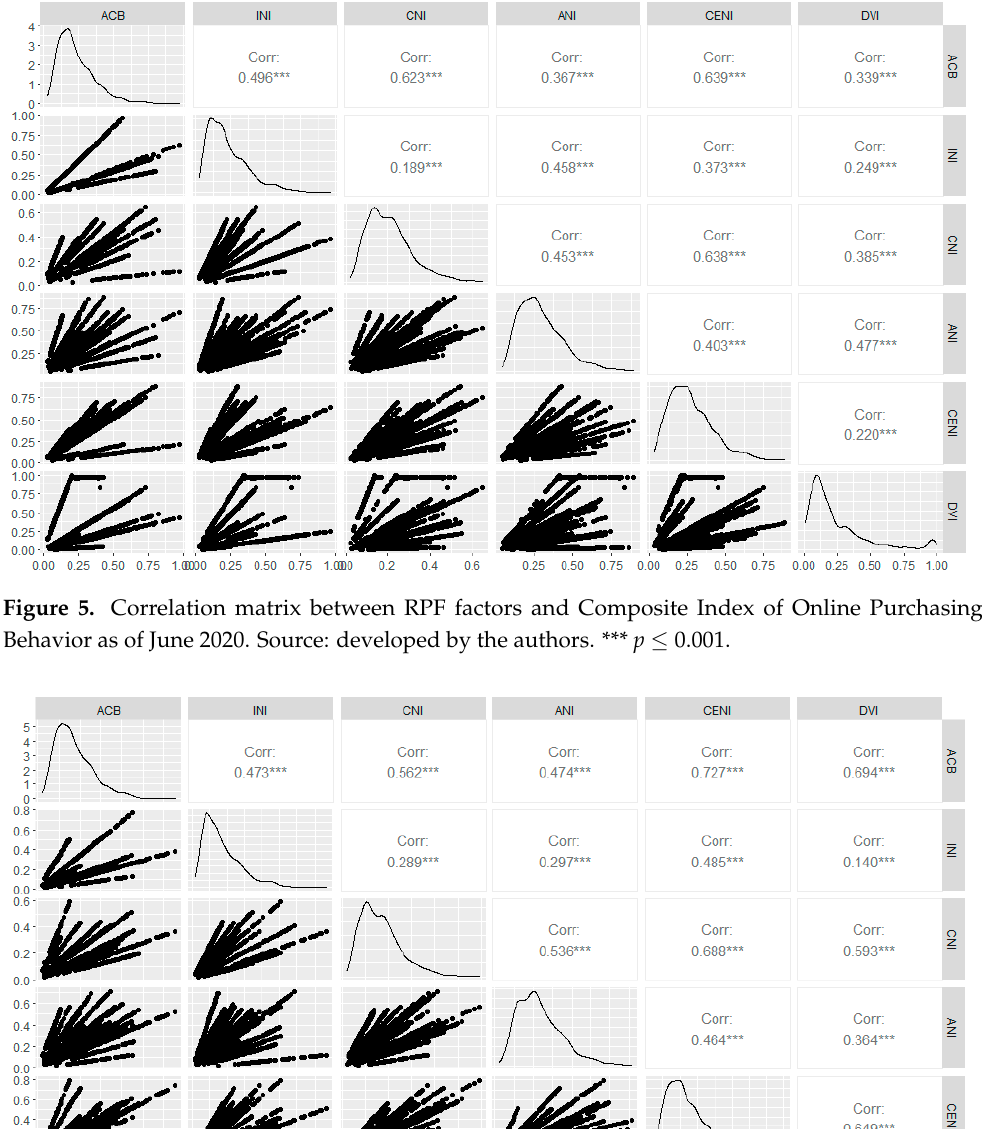
Figure 6. Correlation matrix between RPF factors and Composite Index of Online Purchasing Behavior as of August 2020. Source: developed by the authors. *** p ≤ 0.001.